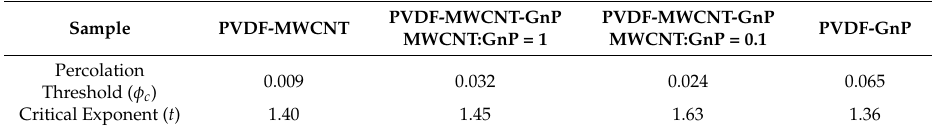
Figure 3. The electrical conductivities of PVDF nanocomposite samples as a function of filler loadings: ( a ) a logarithmic plot showing the percolation behaviors of σ with increasing filler loadings; and ( b ) a linear plot demonstrating differences in σ values of PVDF nanocomposites. Table 1. The percolation thresholds and the critical exponents of PVDF nanocomposite foams coated with different types of carbon nanoparticles.